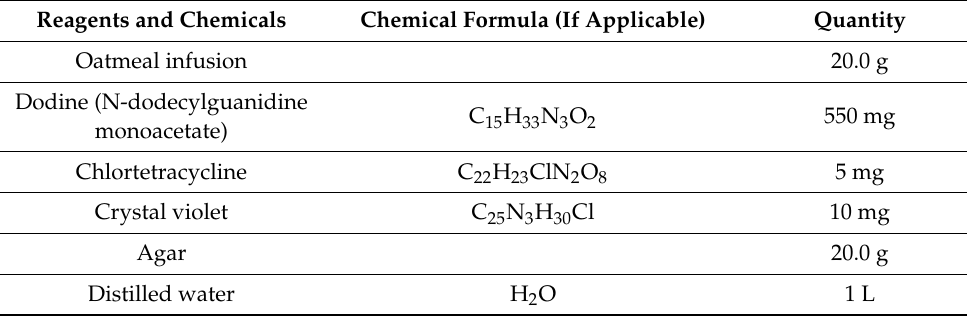
(15) Sabouraud-2-Glucose agar (S2GA). Reagents and